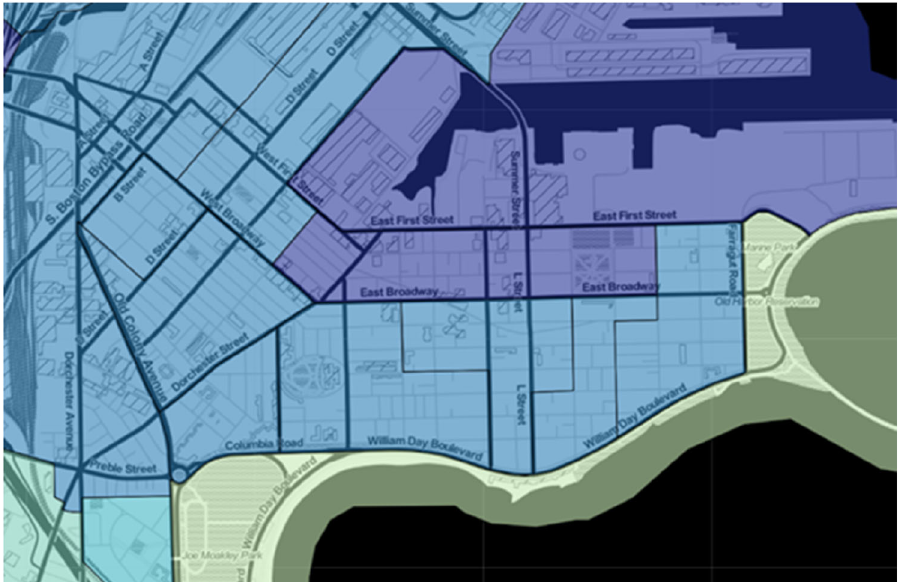
Fig. 12 Road network diagram in